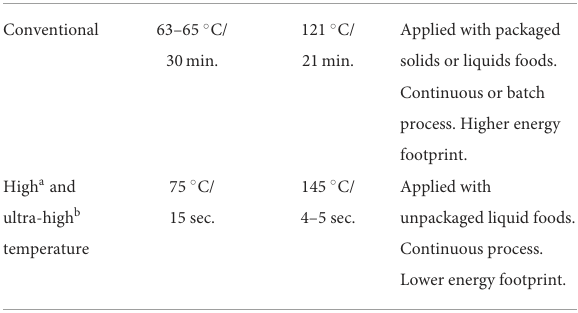
TABLE 1 Industrial food thermal treatments. Pasteurization Sterilization